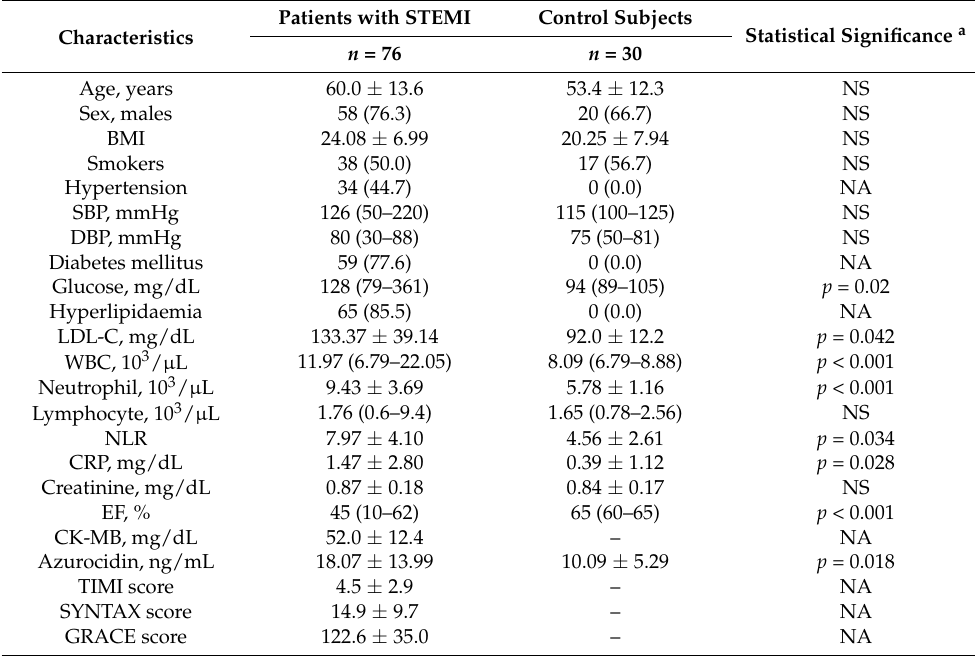
Table 1. Baseline demographic, clinical and laboratory data of patients ( n = 76) with ST segment elevation myocardial infarction (STEMI) and age- and sex-matched healthy control subjects ( n = 30). Characteristics